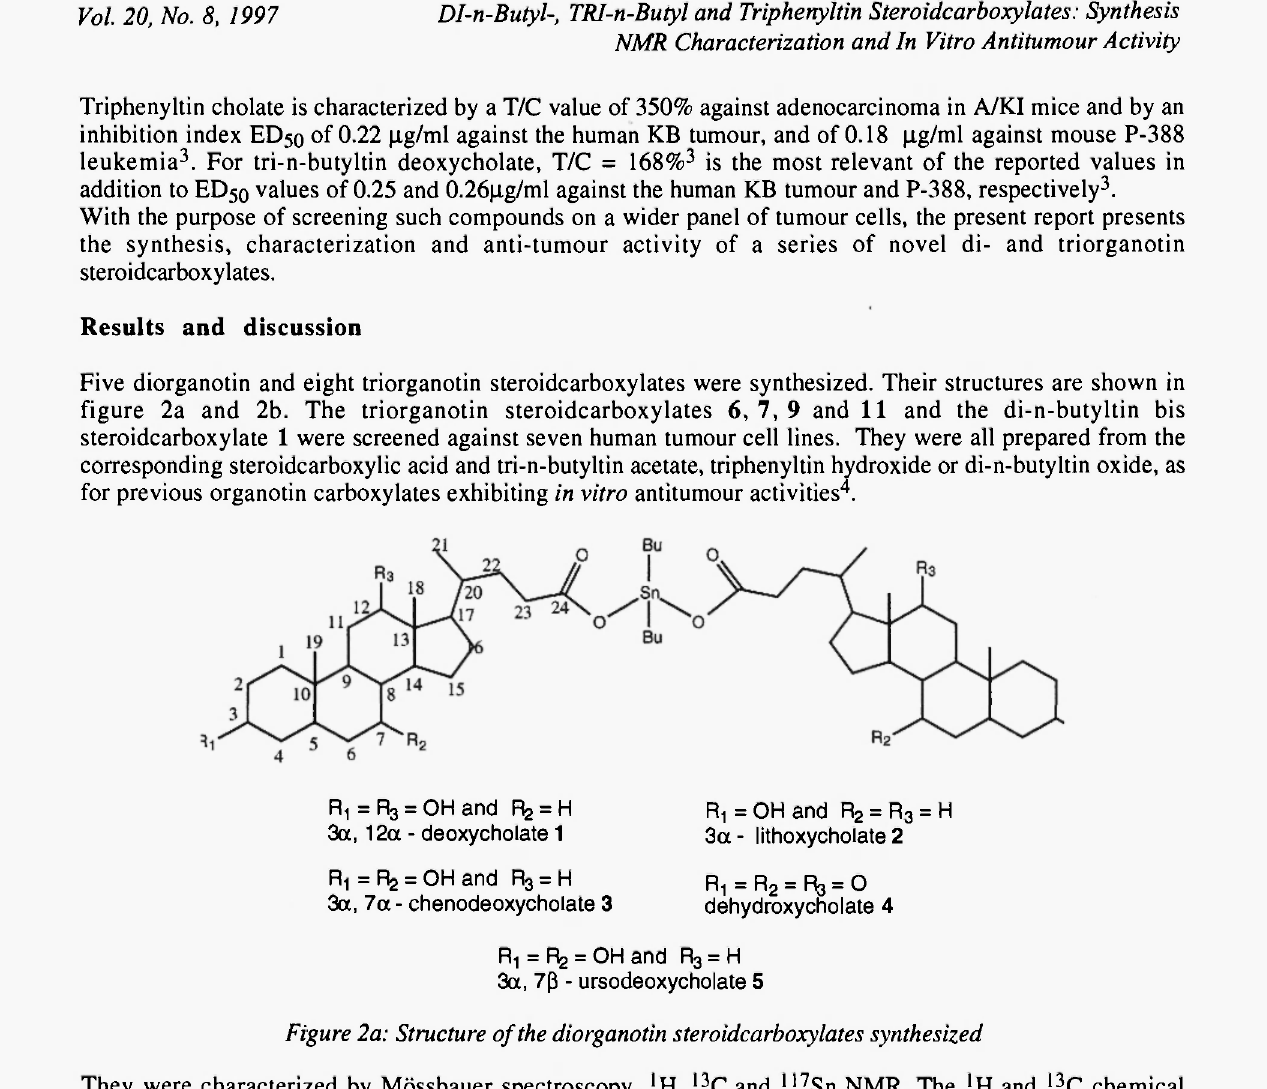
Figure 2a: Structure of the diorganotin steroidcarboxylates